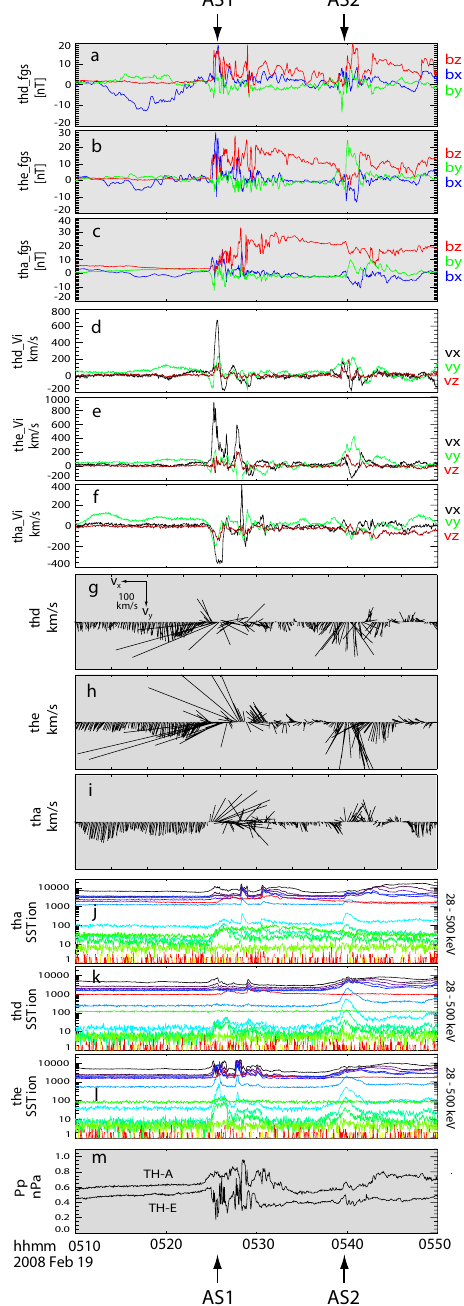
AS1 Fig. 7. Spacecraft data from three THEMIS probes (TH-D, TH-E, and TH-A, in this order) on 19 February 2008: (a–c) magnetic field; Fig. 6. Riometer data on 19 February 2008 ordered along two lines: (d–f) plasma flow velocities calculated using data from both ESA the E-W line and the Churchill line. Red circles show the locations and SST instruments; (g–i) vector plots of flow velocities projected of the first (AS1) and second (AS2) auroral spiral. The appear- onto the X-Y GSM plane; (j–l) differential ion energy flux for var- ance times for both auroral spirals are indicated at the bottom of ious energy channels from the SST instrument in the range from the figure by arrows, labeled AS1 and AS2. The red dashed lines 25keV to ∼ 500keV; and (m) particle pressure derived from both emphasize the time delay of the formation of absorption bays. ESA and SST